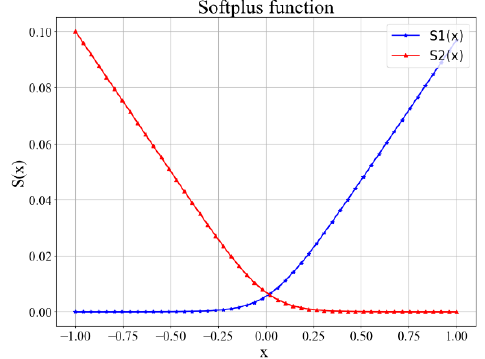
Figure 10. Curves of two Softplus functions.